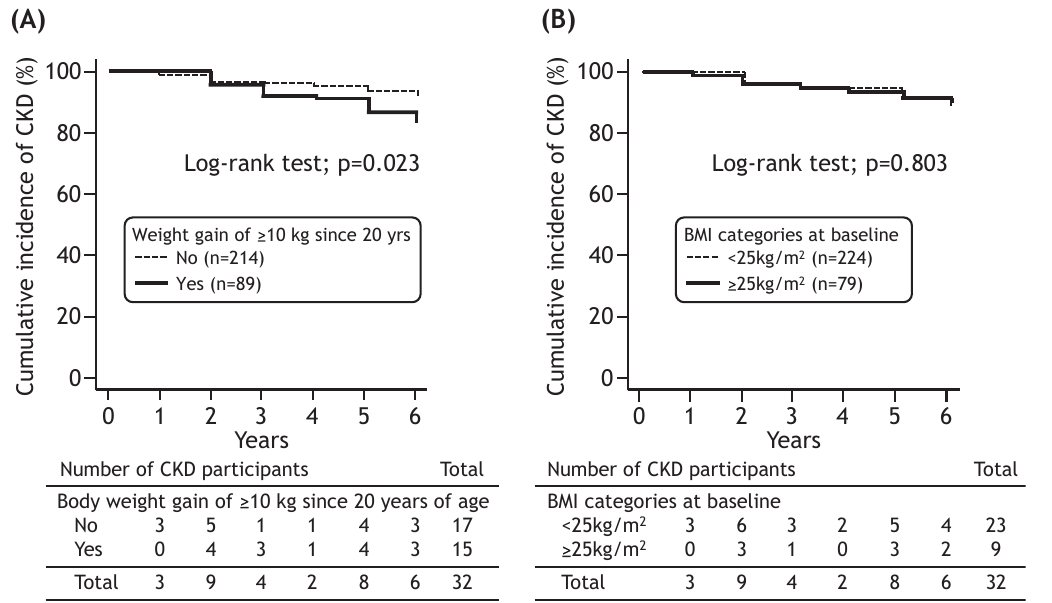
Figure 2. The cumulative incidence of CKD after 6 years follow-up period in participants with and without a body weight gain of ; 10kg since 20 years of age (A) and current overweight (BMI at baseline ; 25kg / m 2 , [B]). CKD, chronic kidney disease; BMI, body mass index.